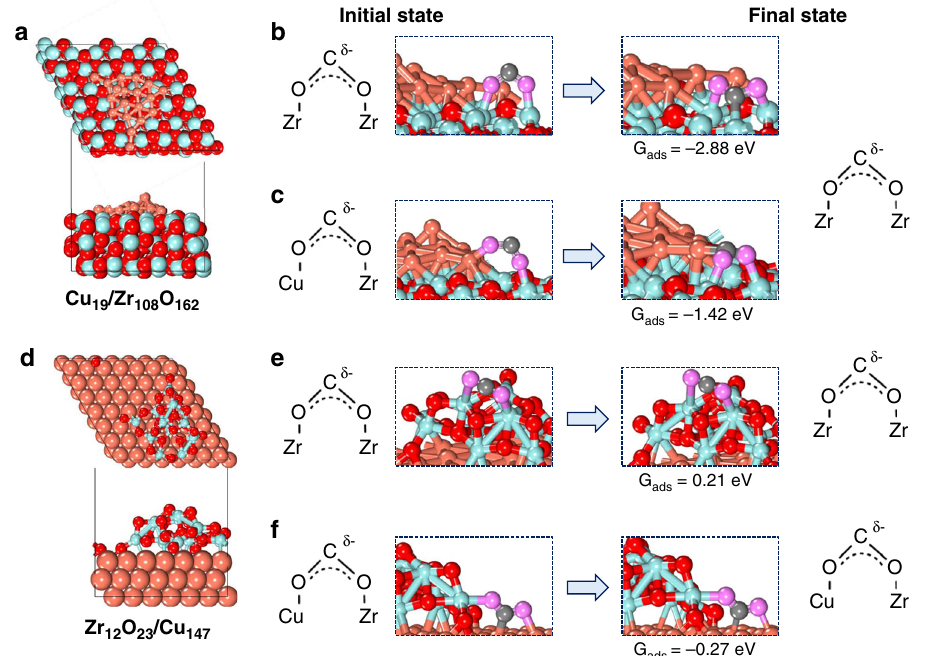
Fig. 6 The con fi guration and adsorption free energy of CO 2 on different models. The con fi gurations of a Cu 19 /Zr 108 O 162 presents Cu/ZrO 2 catalyst, the initial states of CO 2 adsorbed on Cu/ZrO 2 b O-Zr, c O-Cu; the con fi gurations of d Zr 12 O 23 /Cu 147 presents ZrO 2 /Cu catalyst, the initial states of CO 2 adsorbed on inverse ZrO 2 /Cu e O-Zr, f O-Cu. The salmon, cyan, black and red spheres represent Cu, Zr, C and O atoms, respectively. The pink spheres represent the O atoms in CO 2